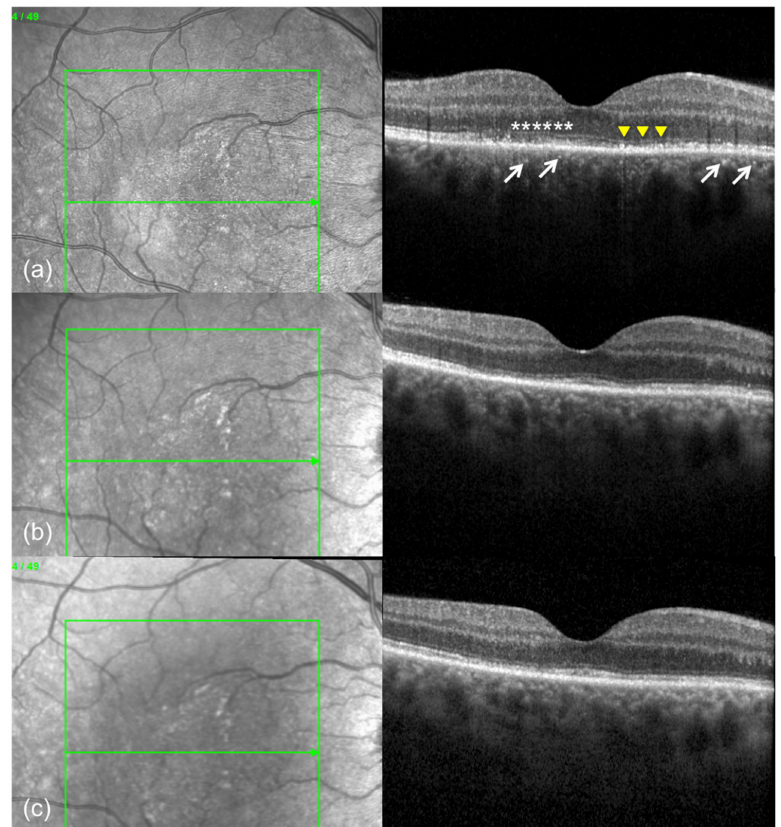
Figure 3: (a) Spectral domain optical coherence tomography (SD-OCT) scan of the right eye at presentation shows disruption of the ellipsoid zone (white asterisks), nodular thickening of the retinal pigment epithelium (yellow arowheads) and punctate hyperreflectivity in the inner choroid (white arrows). SD-OCT scan 1 week after presentation (b) and 2 weeks after presentation (c) show gradual recovery of the ellipsoid zone and retinal pigment